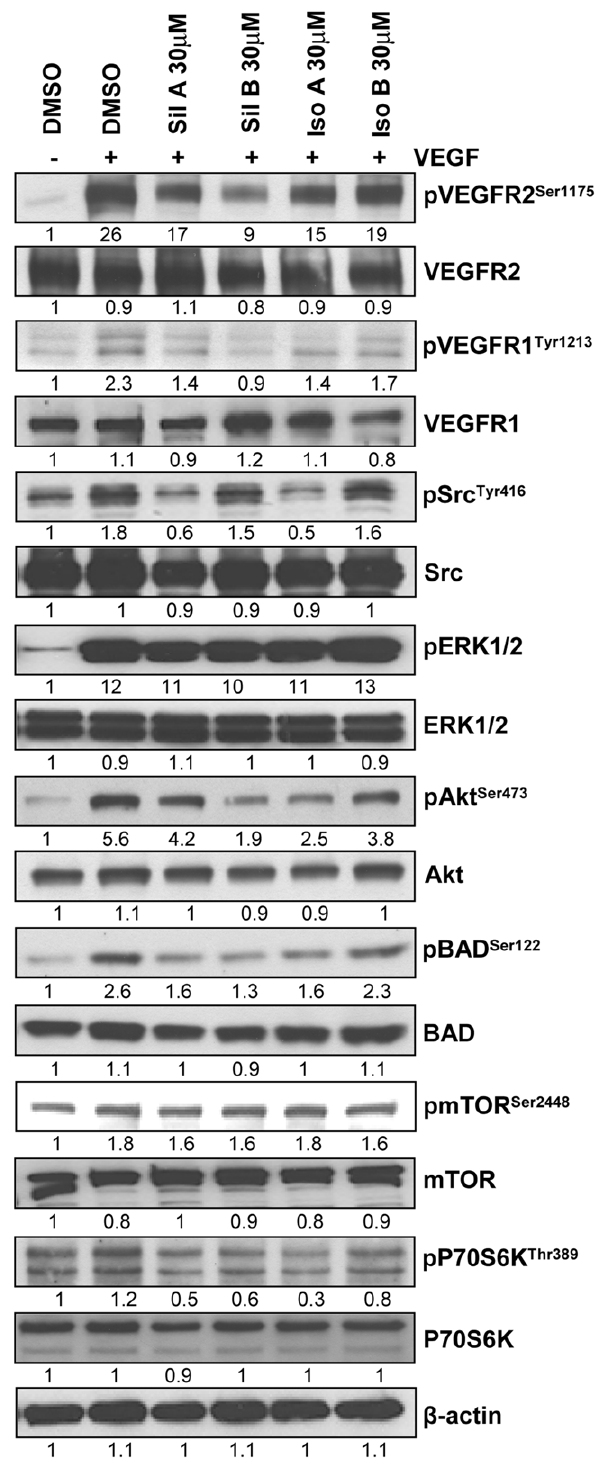
Figure 8. Effect of flavonolignans on VEGF-induced signaling cascade in HUVEC. HUVEC were serum starved for 22 h, treated with diastereoisomers for 2 h and stimulated with VEGF (10 ng/ml) for 10 minutes. Total cell lysates were prepared and analyzed for mentioned signaling molecules. The densitometry values presented below the bands are ‘fold change’ compared to control after loading control ( b -actin) normalization.